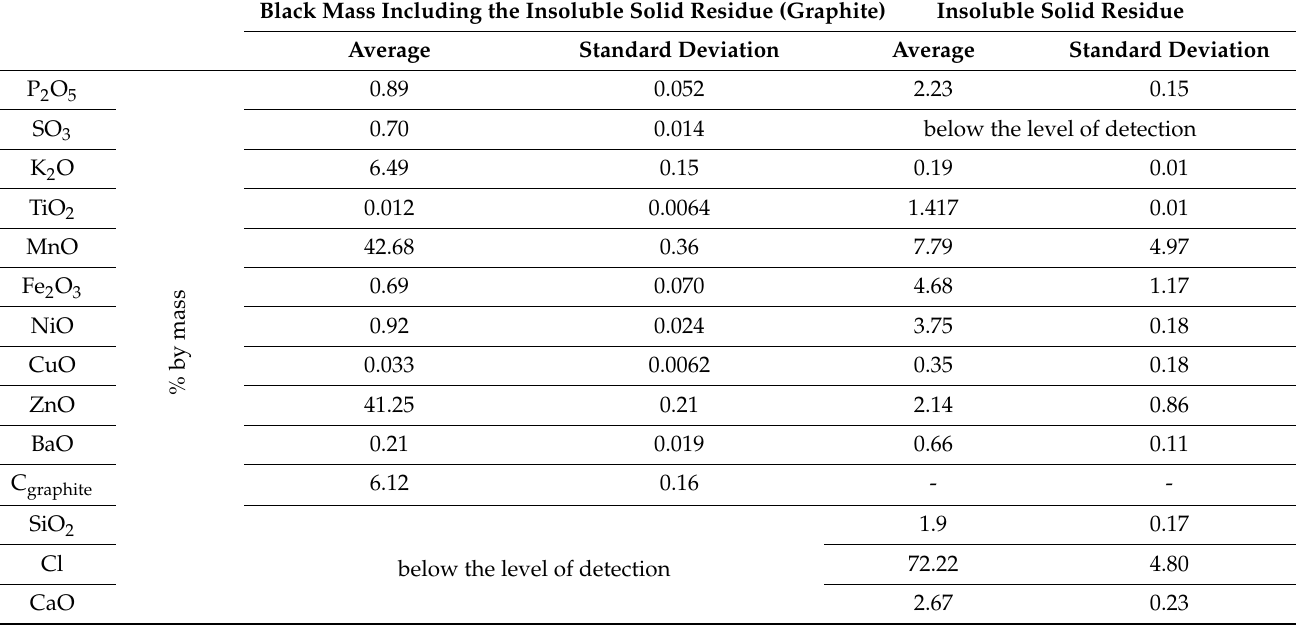
Table 2. Chemical composition of the initial material and insoluble solid